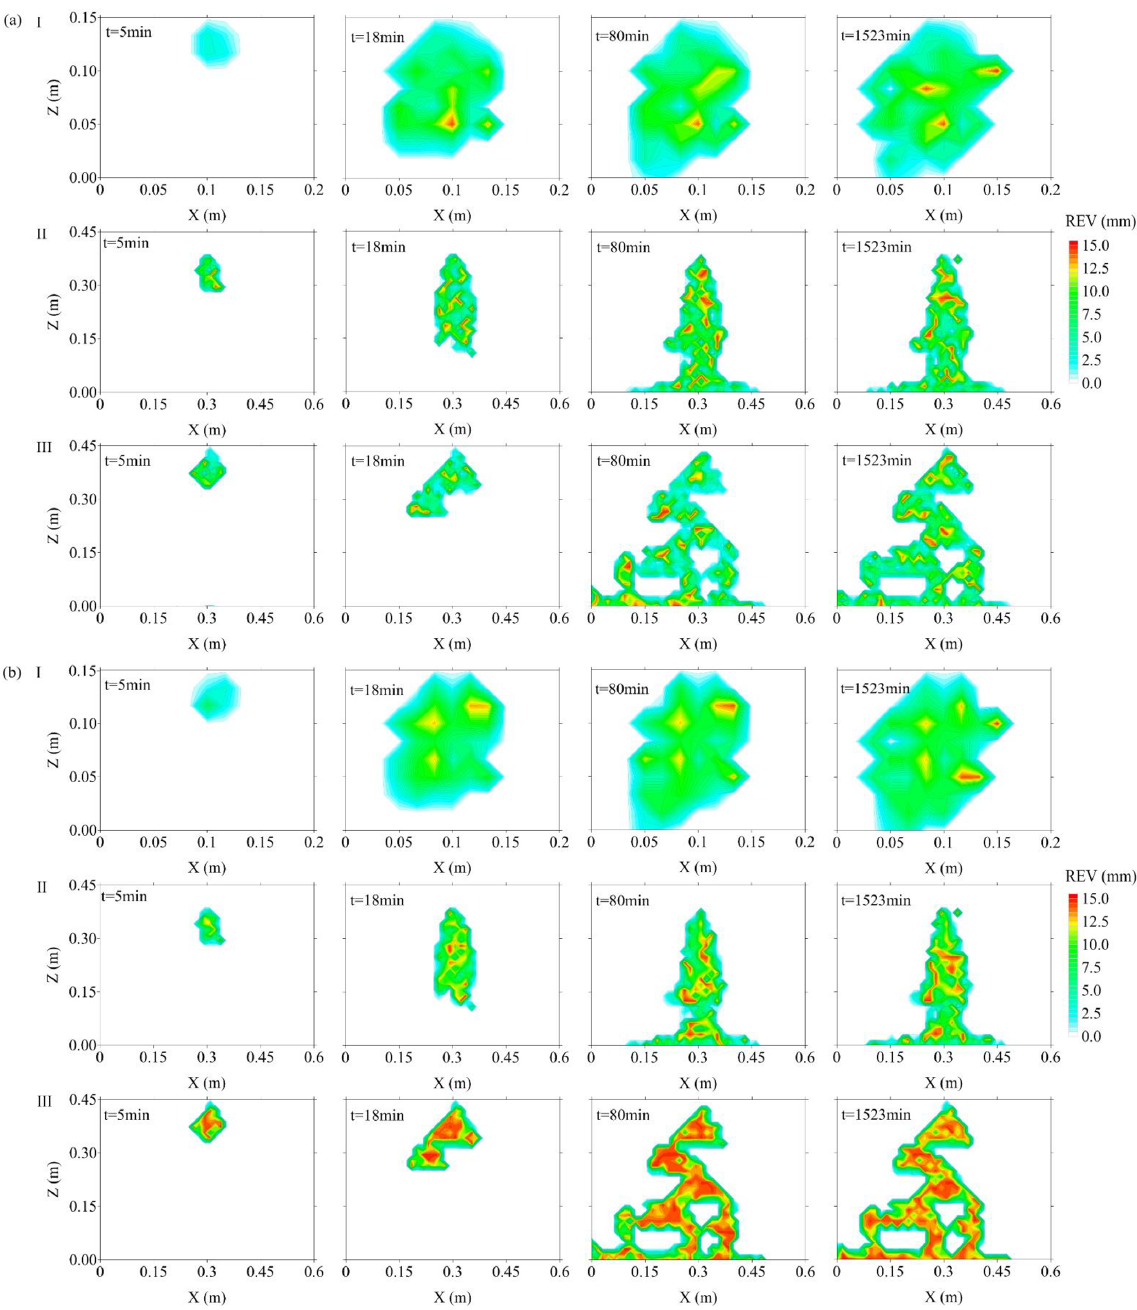
Figure 6. (a) The distributions of S o -REV sizes during 0–1523min for Experiments I–III; (b) the distributions of A OW -REV sizes during 0–1523min for Experiments